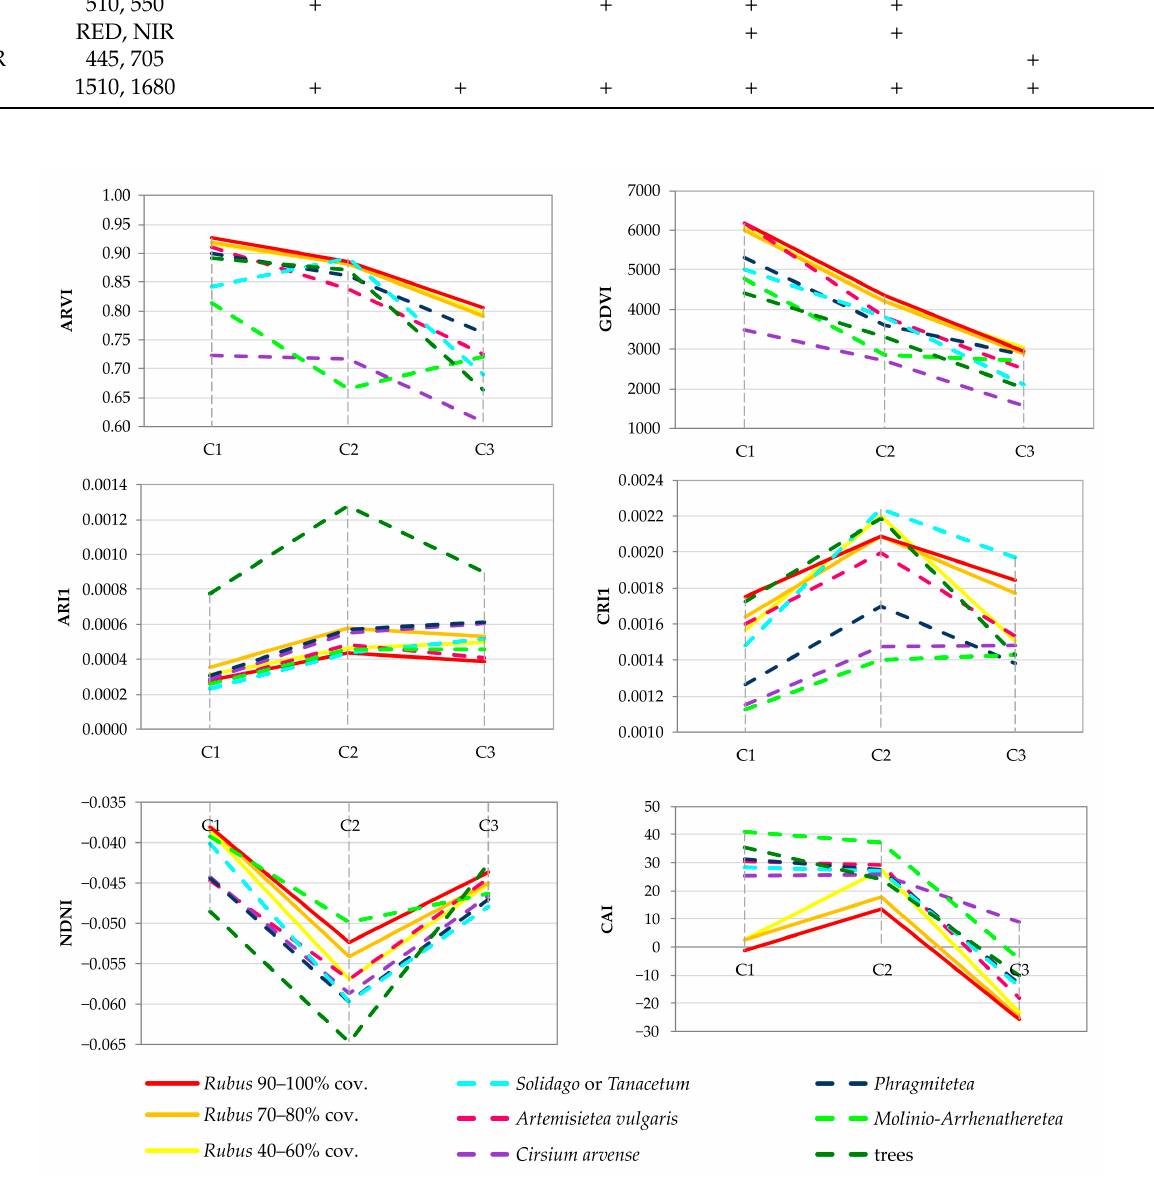
Figure 8. The average values of the selected vegetation indices for the analysed R. caesius and other vegetation classes for the three